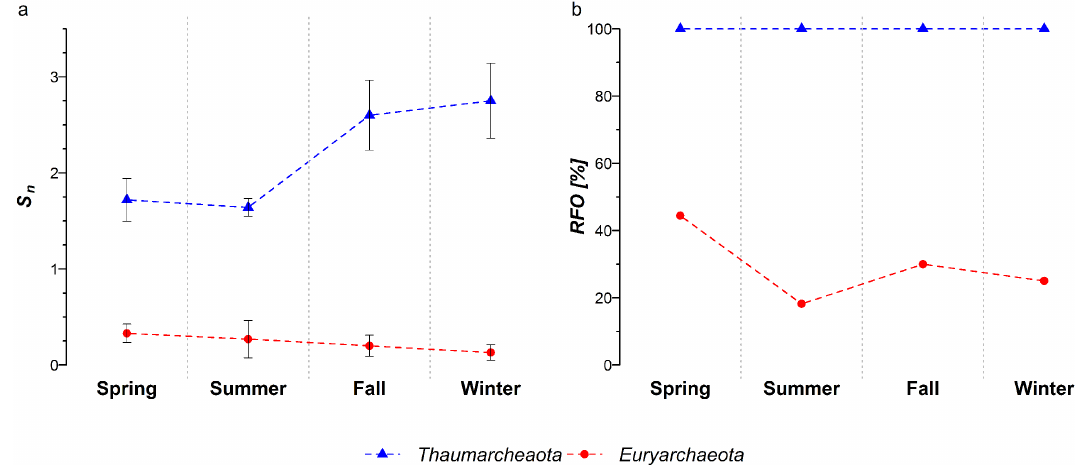
Figure 3. Overview of the species richness in Mainz. Seasonal variations in the species richness of Euryarchaeota and Thaumarchaeota in total suspended particles (TSP) normalized by the number of investigated air samples (a) and in the relative frequency of occurrence (RFO) of the phyla Euryarchaeota and Thaumarchaeota in Mainz, Germany (b)